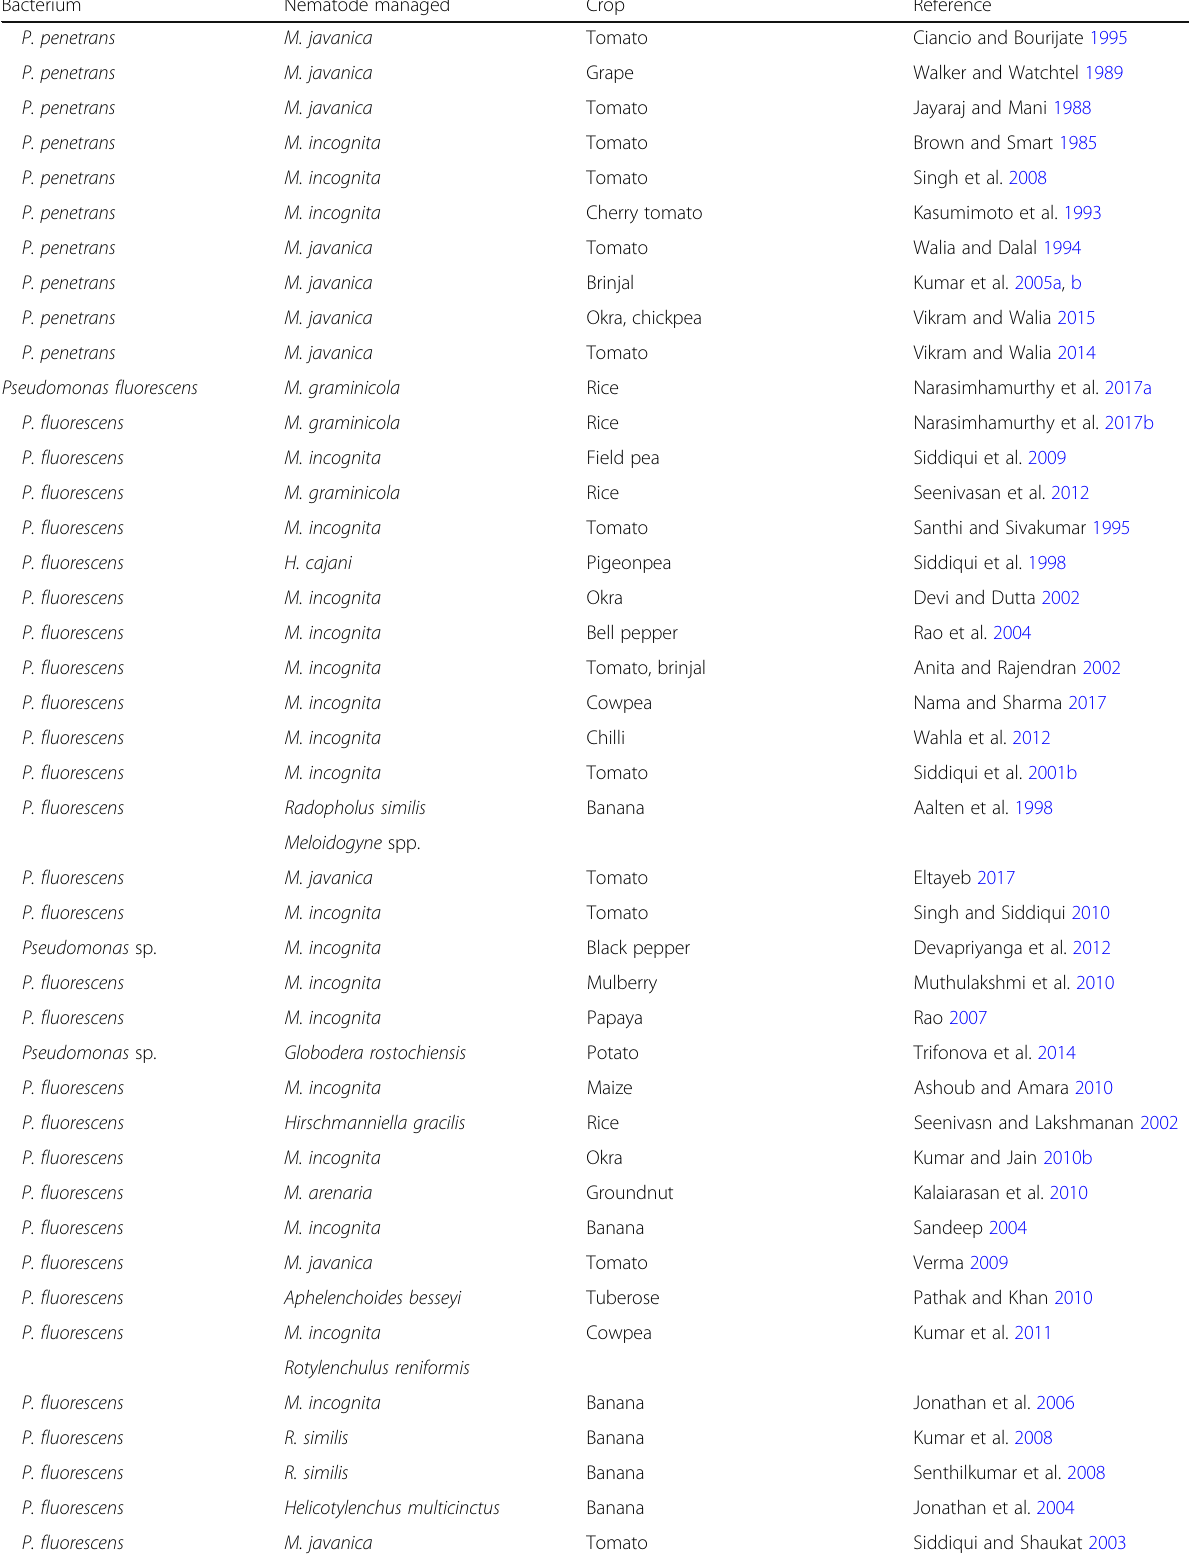
Table 6 List of bacterial biocontrol agents against phytonematodes infesting agricultural crops (Continued)